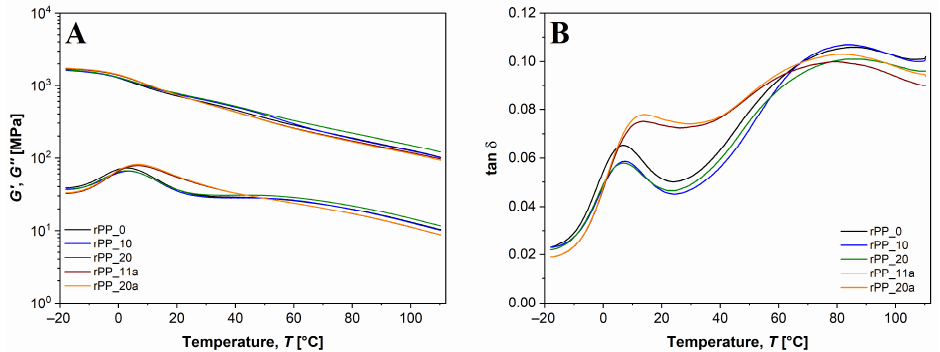
Figure 11. DMA curves: ( A ) storage modulus ( G’ ) and loss modulus ( G” ); ( B ) tan δ of virgin PP and recycled PP without and with the additive. Table 4. Dynamic mechanical analysis (DMTA) results of virgin PP and recycled PP without and with the additive.